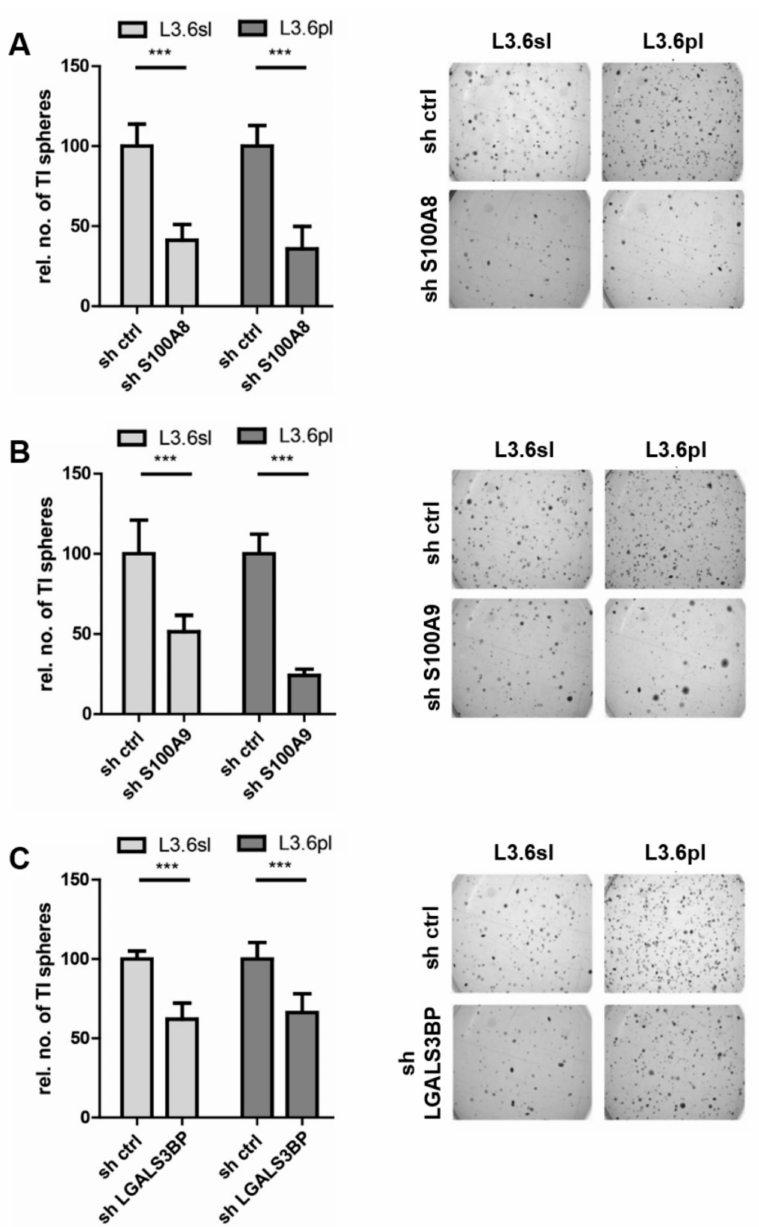
Figure 4. Knockdown of TIC genes S100A8, S100A9 and LGALS3BP reduces tumor-initiating (TI) sphere formation of pancreatic TICs. Relative numbers (rel. no.) of spheres upon transduction with control shRNA (sh ctrl) or shRNA against S100A8 ( A ), S100A9 ( B ), and LGALS3BP ( C ) are given as bar charts (left column). Representative images of TI sphere growth are depicted on the right column. Error bars represent standard error of the mean. Statistical significances were assessed by an unpaired t-test (* for p ≤ 0.05, ** for p ≤ 0.01, and *** for p ≤ 0.001, n = 12). Additional validation experiments were conducted in Panc1 cells (Supplementary Figure